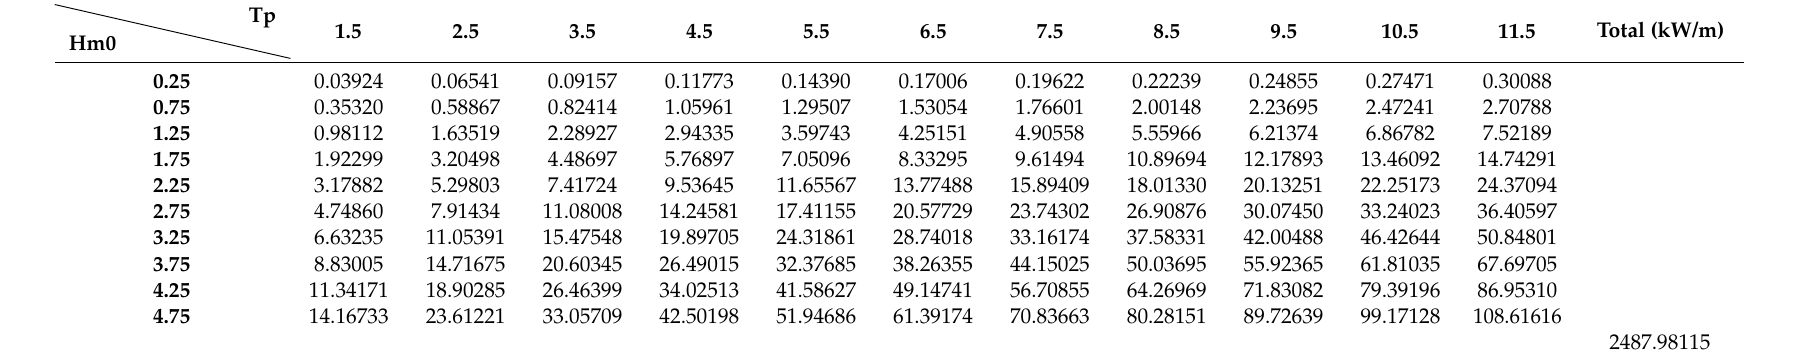
Table 2. Theoretical power for each wave condition